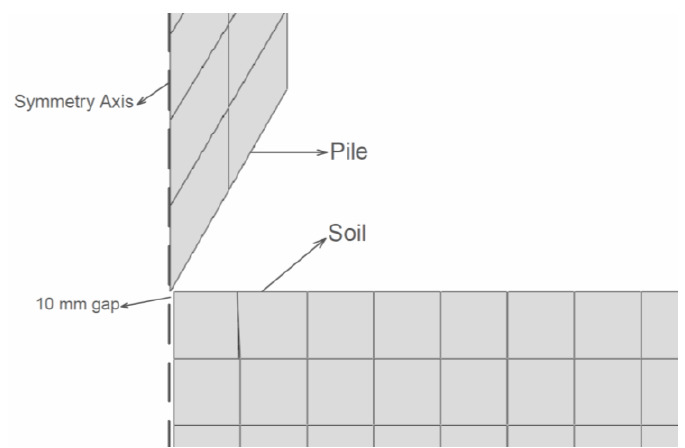
Fig. 2. A 10 mm gap between soil elements and symmetry axis